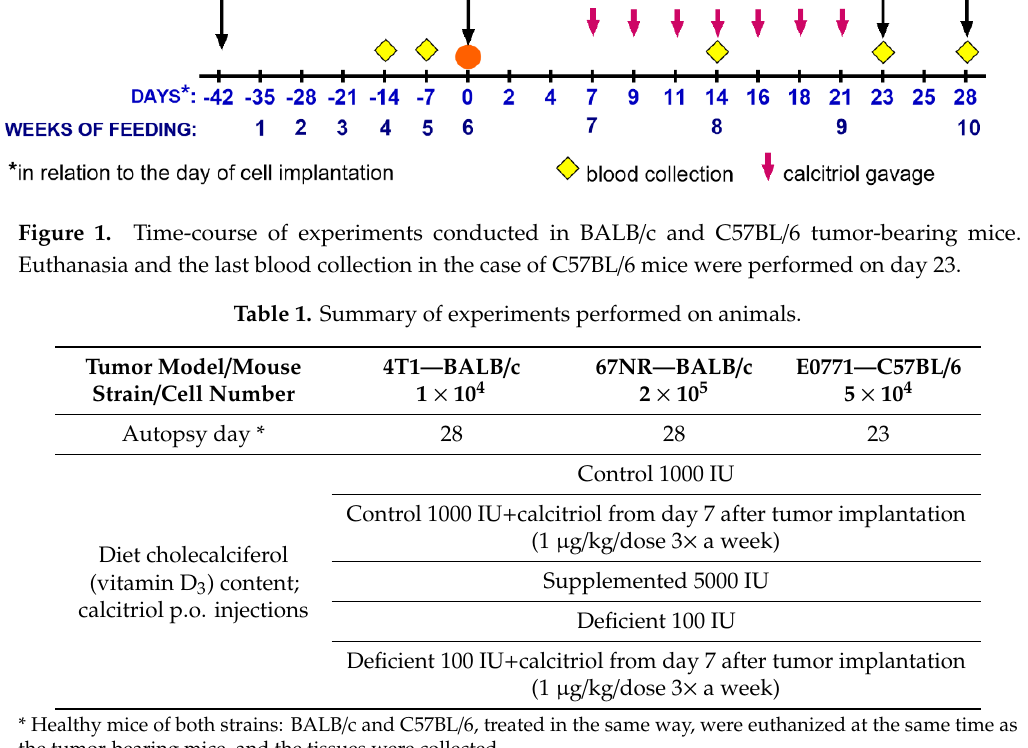
Table 1. Summary of experiments performed on animals.